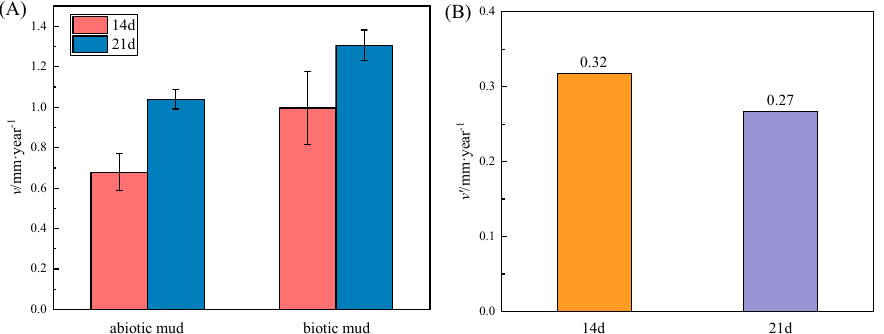
Figure 3. ( A ) Corrosion rate of AZ31B specimens in biotic and abiotic systems, ( B ) versus relative corrosion rate of SRP in mudflat environment.